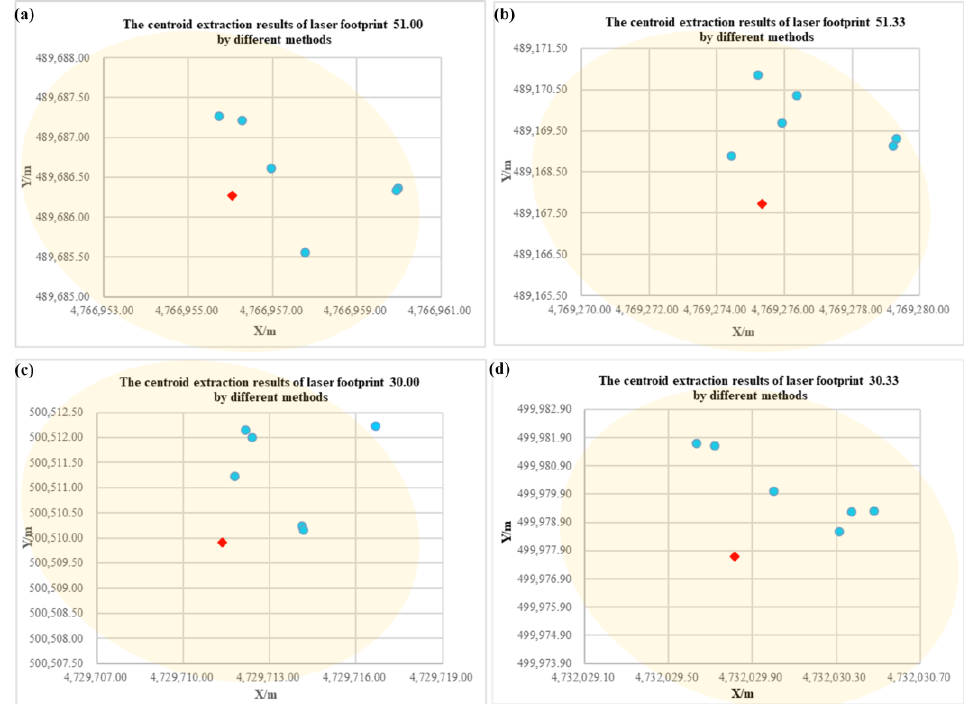
Figure 8. Schematic diagrams for centroid extraction results of experimental data using different methods; the diamond-shaped points are the centroid results extracted using the method proposed in this paper, the rounded points are the centroid results extracted using the other six methods, and the orange ellipses represent the laser spots.